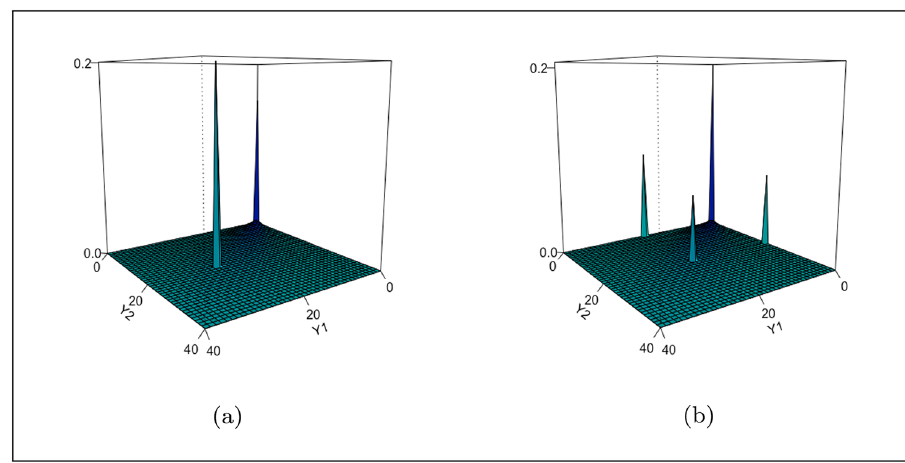
Figure 3: Bivariate multiple - in fl ated negative binomial distribution using a Gaussian copula with parameters ( a )